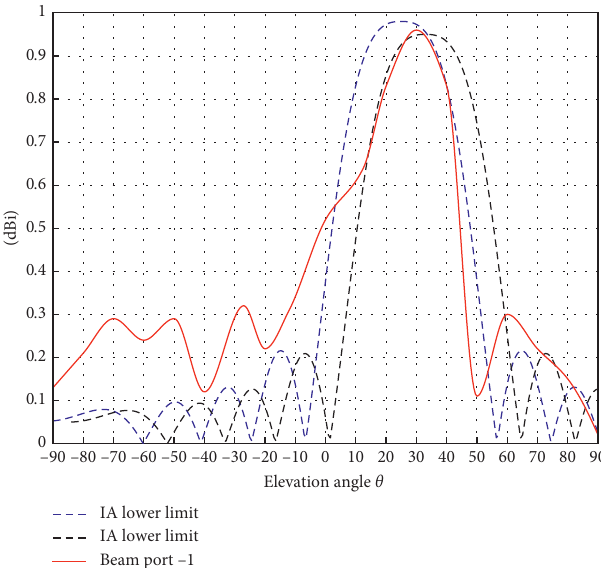
Figure 29: Measured vs. simulated beam pattern considering the lower and upper IA limits. Beam port 3, beam steering at +30 degrees.